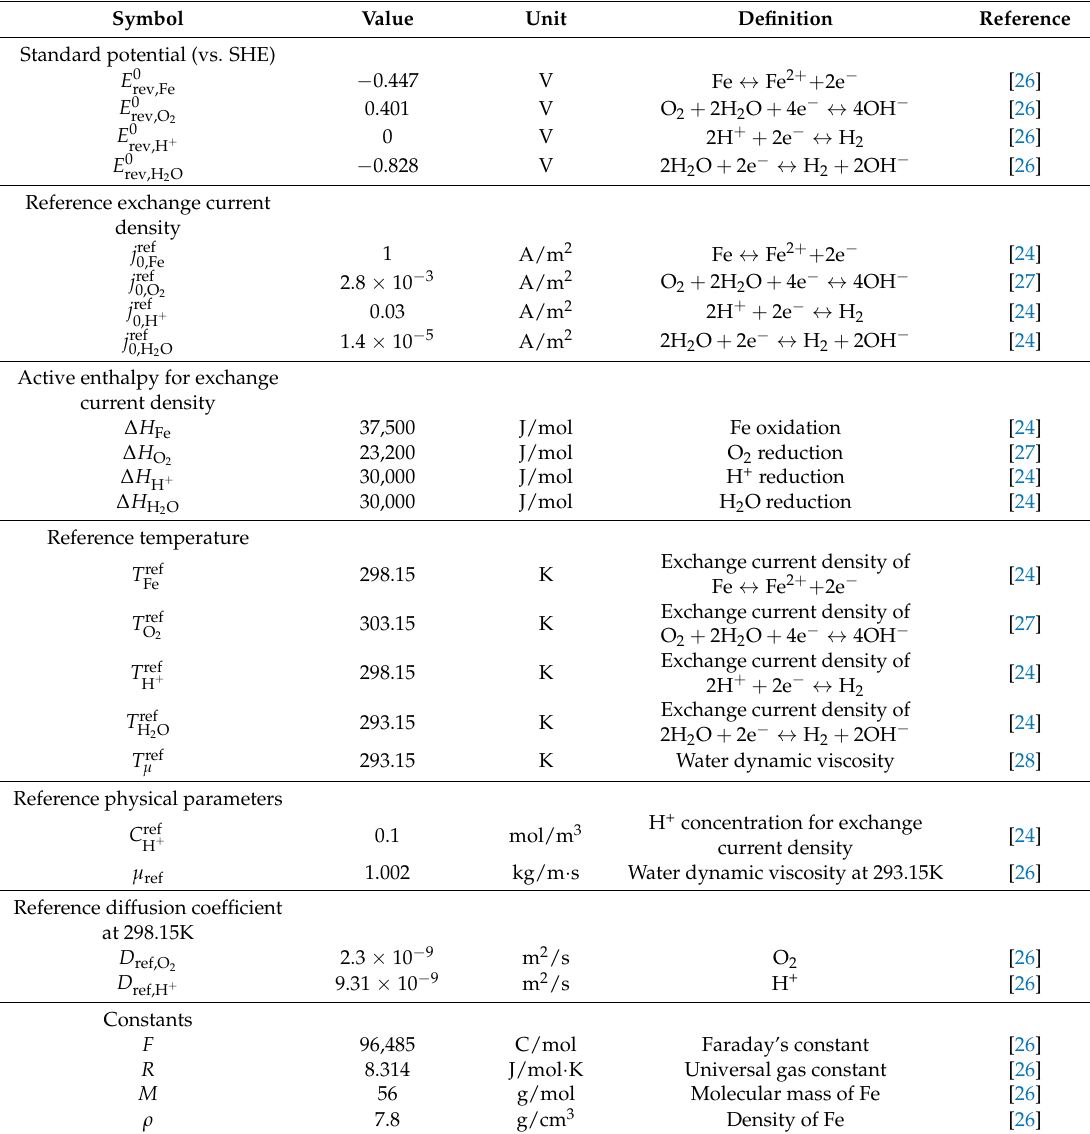
Table 1. Model parameters, variables and